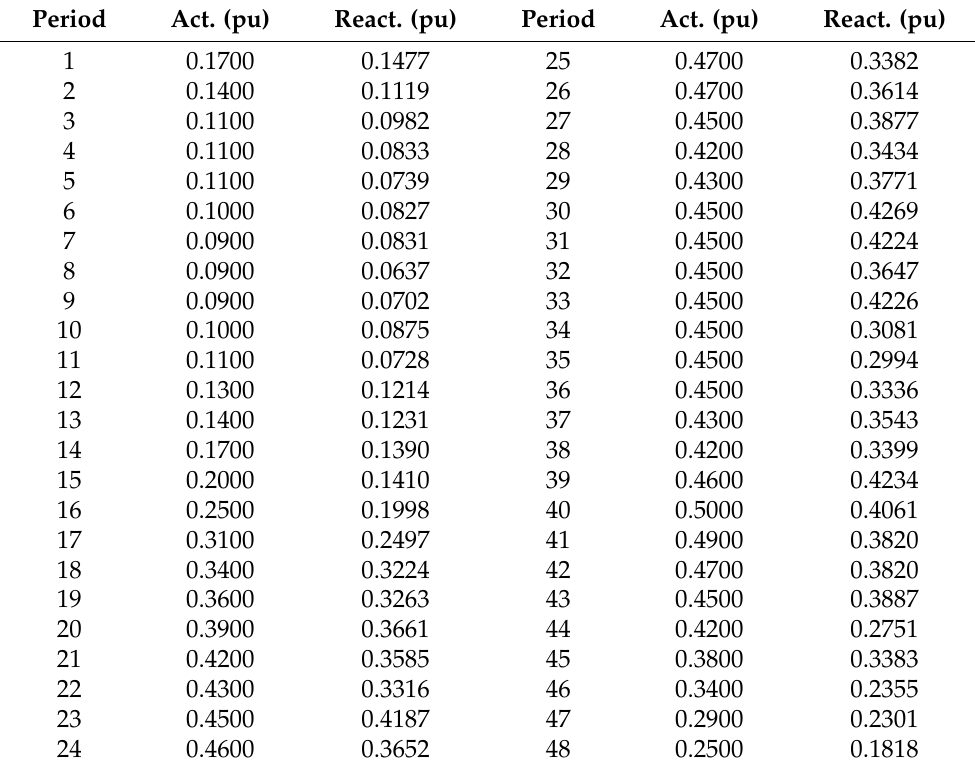
Table 7. Behavior of daily active and reactive power